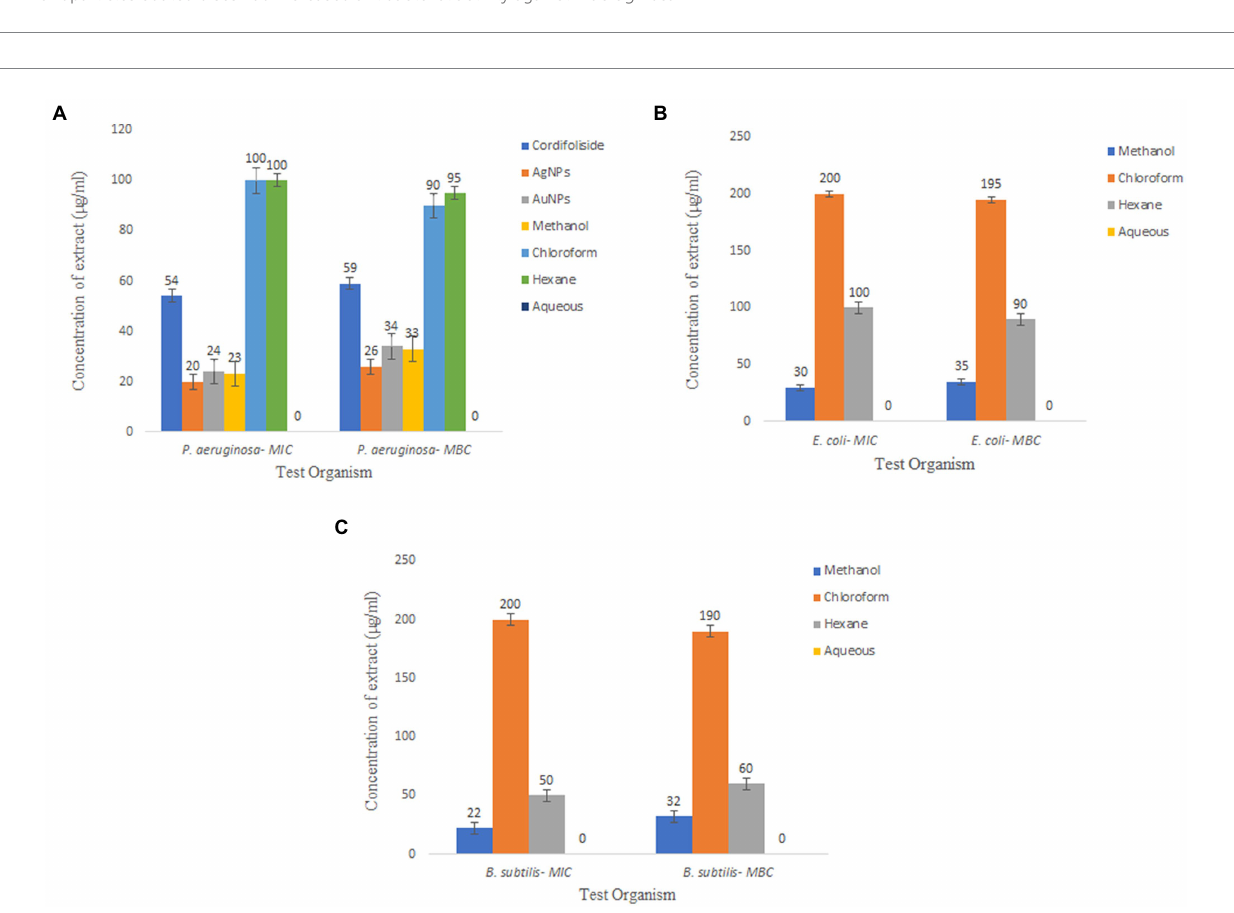
FIGURE 10 Nanoparticles coated discs had increased antibacterial activity against P. aeruginosa.